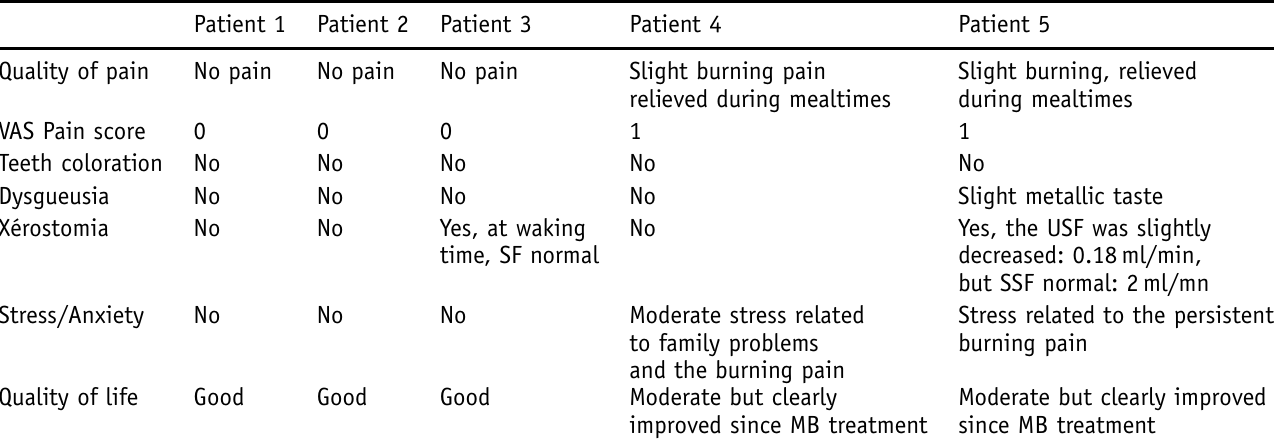
Table IV. Characteristics of the BMS patients 6 months after MB treatment. VAS = Visual Analogic Scale (VAS). USF/SSF = Unstimulated and Stimulated Salivary